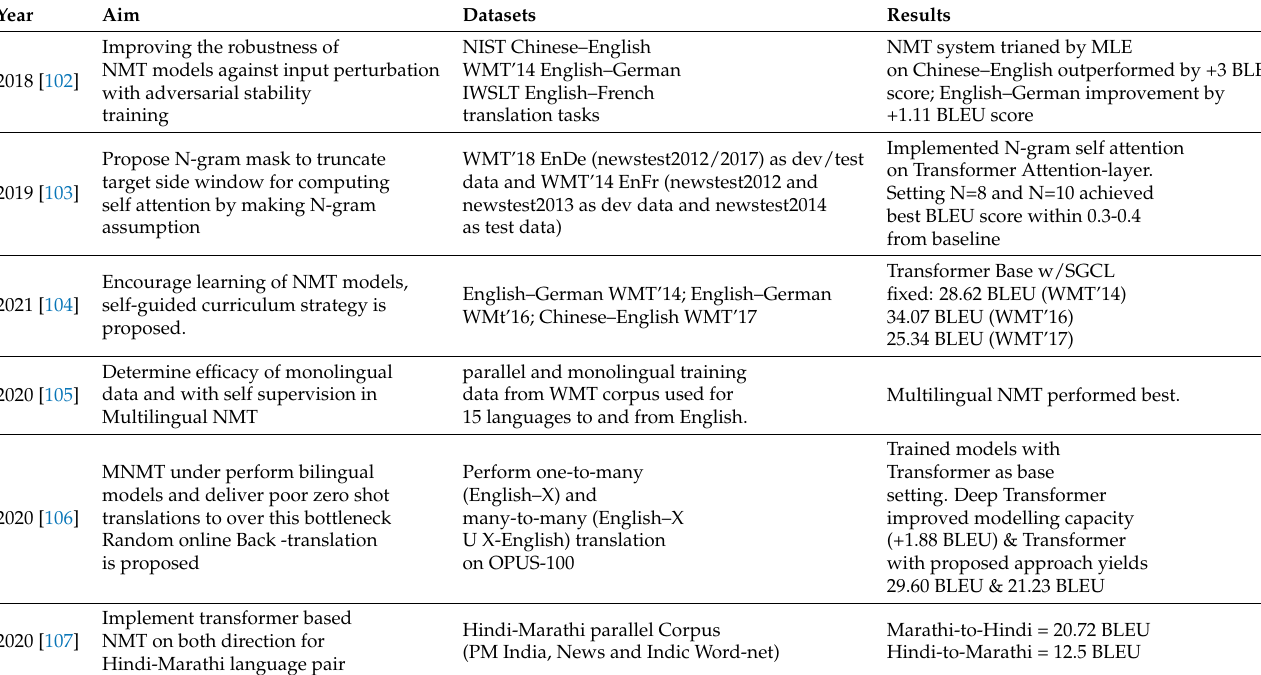
Table 7. Survey for transformer based